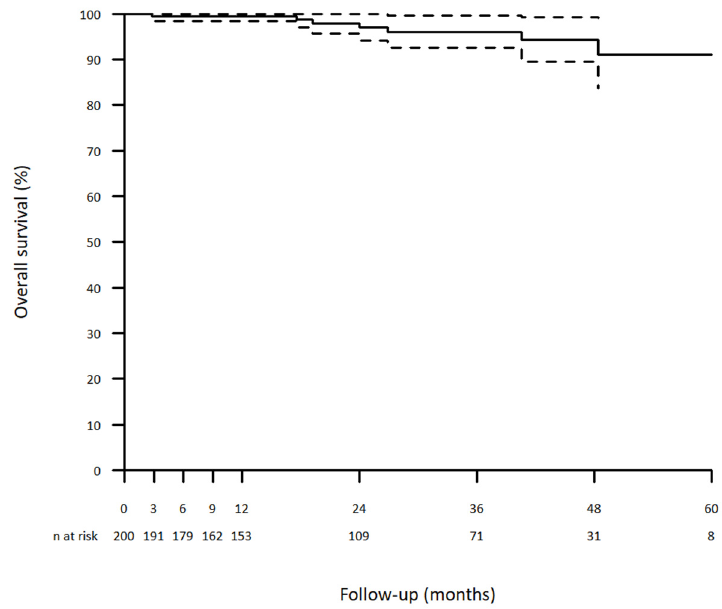
Figure 1. Overall survival curve (+: censored data).